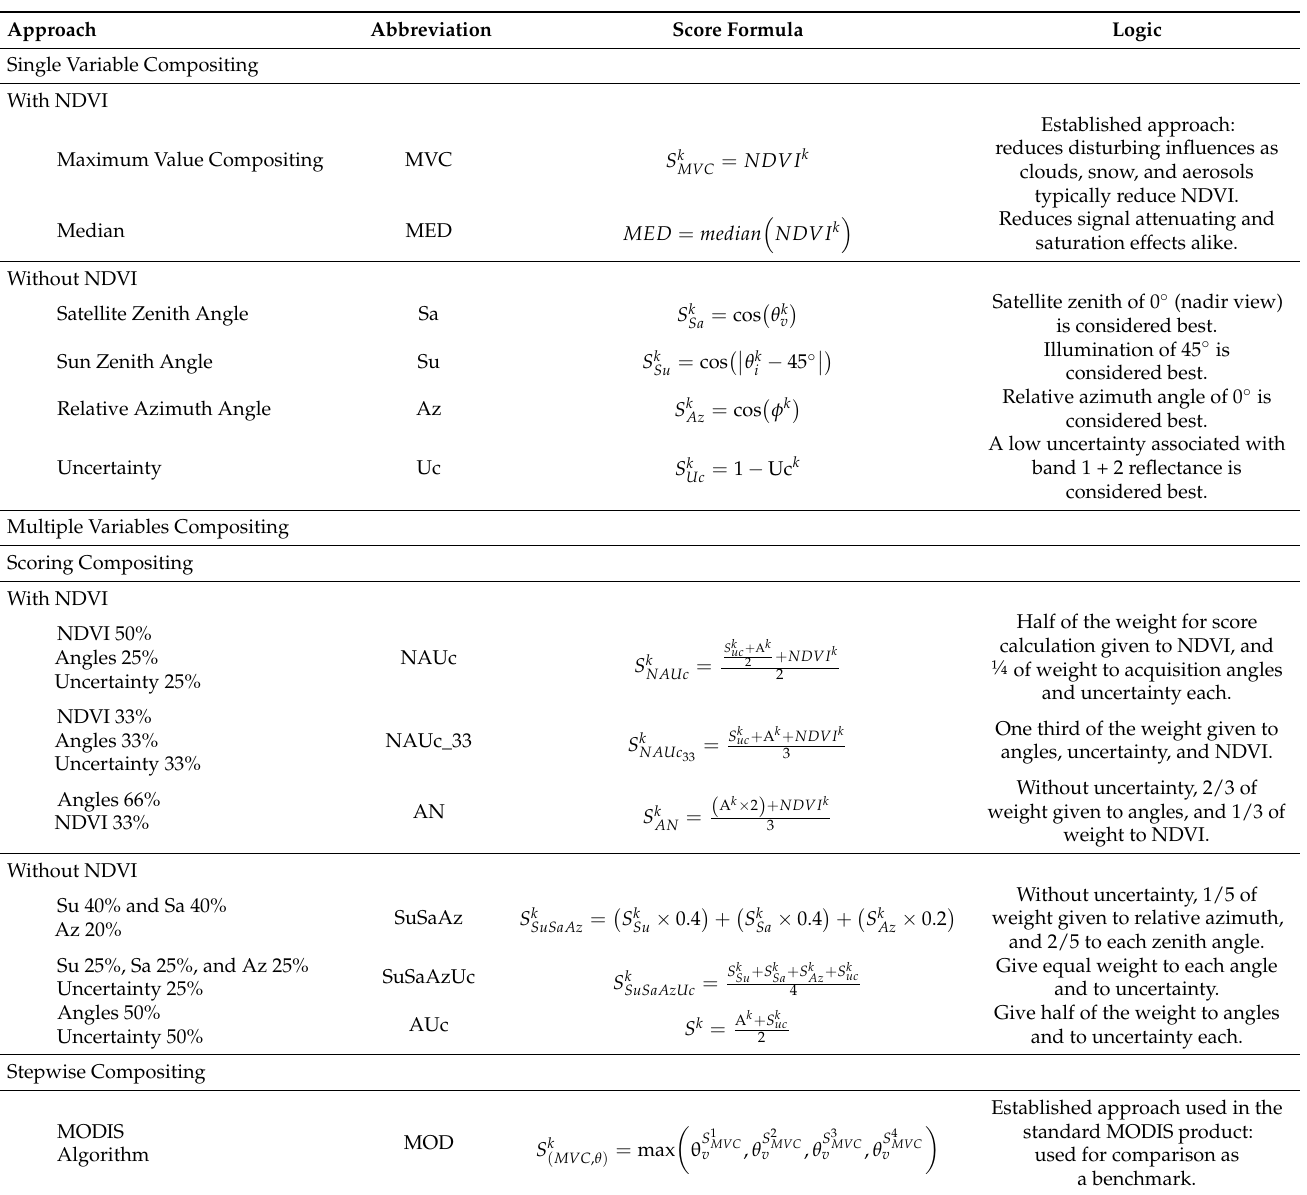
Table 1. Overview on compositing methods: in the third column, the formula for the score calcu- lation is given, where S is the score, k is each single observation, θ i is solar zenith angle, θ v is the view zenith angle, φ is the relative azimuth angle, and A is the average acquisition angles score